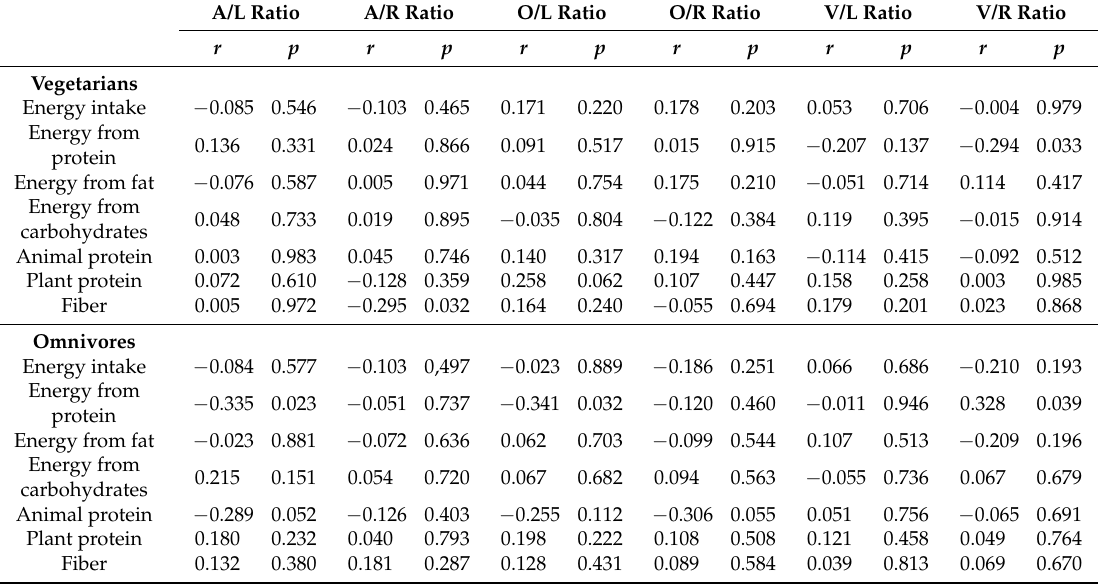
Table 5. Correlation analysis between ratios of anti- to pro-inflammatory adipokines and nutritional parameters in children on vegetarian and omnivorous